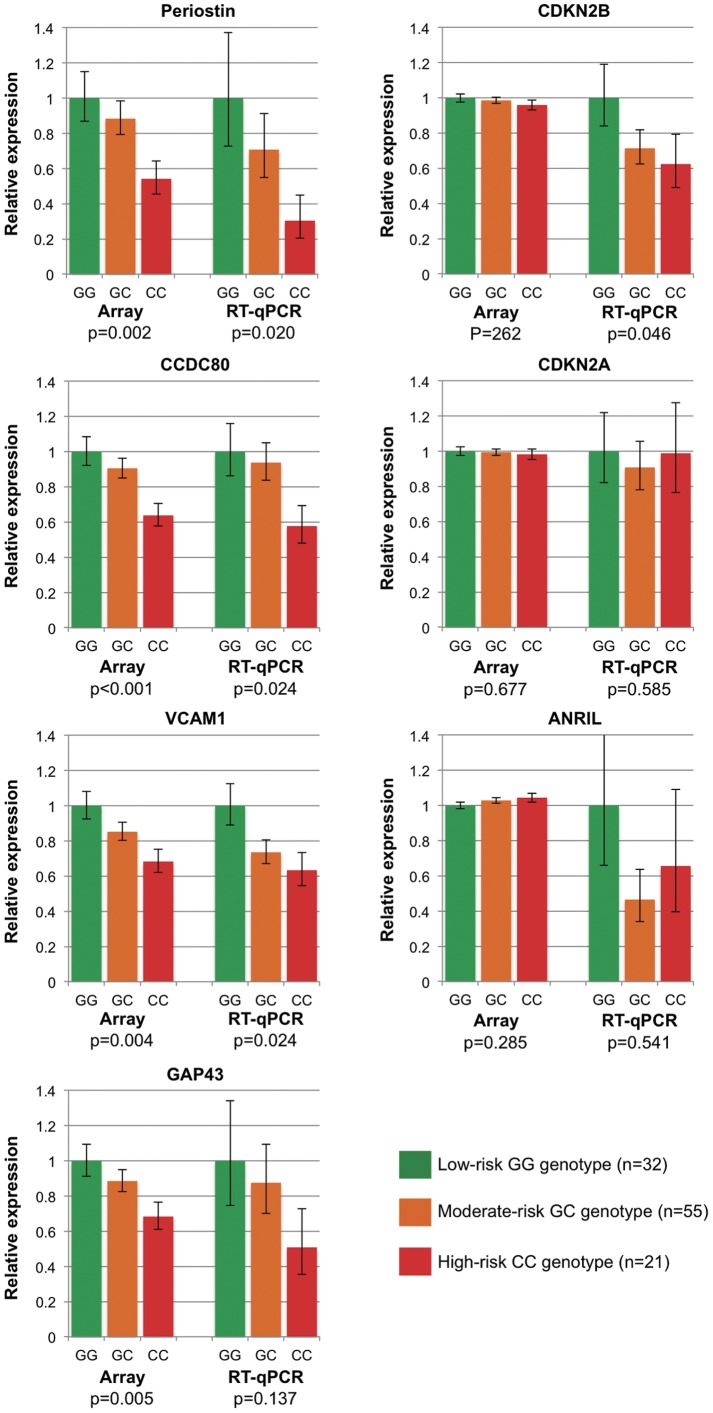
Comparison of microarray data with real-time PCR for selected genes in donor hearts (n = 108).Periostin, CCDC80 (coiled-coil domain containing 80) and VCAM1 (vascular cell adhesion molecule 1), the most differentially expressed genes altered in association with the 9p21.3 risk allele in heart donors, gave an equivalent, statistically significant decrease in expression by microarray and RT-qPCR methods. In contrast to array data, RT-qPCR for CDKN2B, a gene in close proximity to the 9p21.3 risk locus, also showed a significant decrease in expression. No significant association between the 9p21.3 risk allele and expression levels of ANRIL or CDKN2A was detected in these individuals, by either method. The 9p21.3 (rs1333049) low-risk GG genotype is depicted in green; GC heterozygotes (intermediate risk) are shown in orange; the high-risk CC genotype is shown in red. Statistical analysis was performed assuming an additive genetic model and all p-values have been adjusted for age, gender, ethnicity and cause of death.